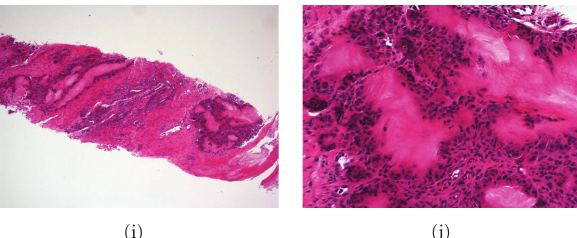
Figure 1: (a) AP and (b) lateral radiographs of right knee demonstrate di ff use faint calcification involving the insertion of the quadriceps tendon at the upper pole of the patella (black arrow). Note the well-defined lytic lesion with marginal sclerosis (arrowheads) in the patella and prepatellar soft tissue swelling. (c) AP and (d) lateral radiographs of the right knee a year later show a comminuted pathological fracture of the mid patella involving the lytic lesion (white arrows) with associated joint e ff usion (star). The faint calcification within the distal quadriceps is again noted (black arrow). Sagittal (e) T1-WSE and (f) T2-WGE and coronal (g) PDSE and (h) STIR MR images confirm a comminuted pathological fracture of the mid and upper patella (black arrows) involving the patellar lesion (white arrows) that displays nonspecific features. However, there is a prominent inhomogeneous soft tissue mass in the prepatellar region, some of which displays low signal intensity (SI) on all sequences that corresponds to the mineralisation noted on the radiographs (arrowheads). (i) Core biopsy at low power and (j) core biopsy at high power, stained with H&E. There are aggregates of amorphous eosinophilic material surrounded by a palisade of histiocytes and giant cells in keeping with tophaceous